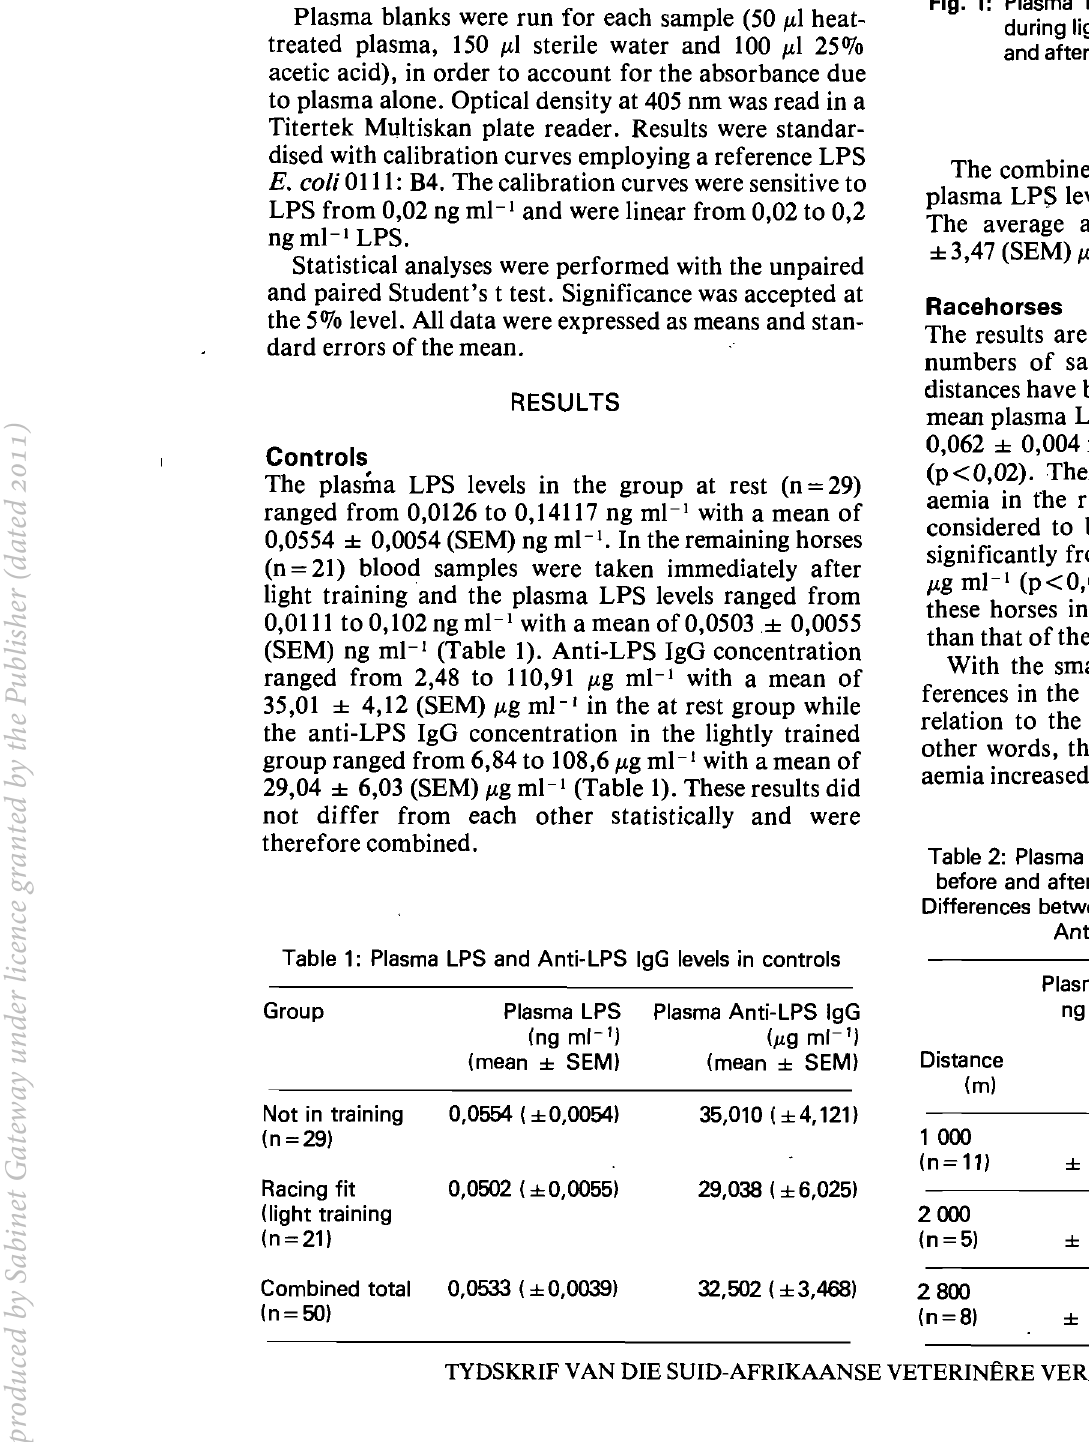
Fig. 1: Plasma LPS and Anti-LPS IgG levels in racehorses during light training (control) and in racehorses before and after a race